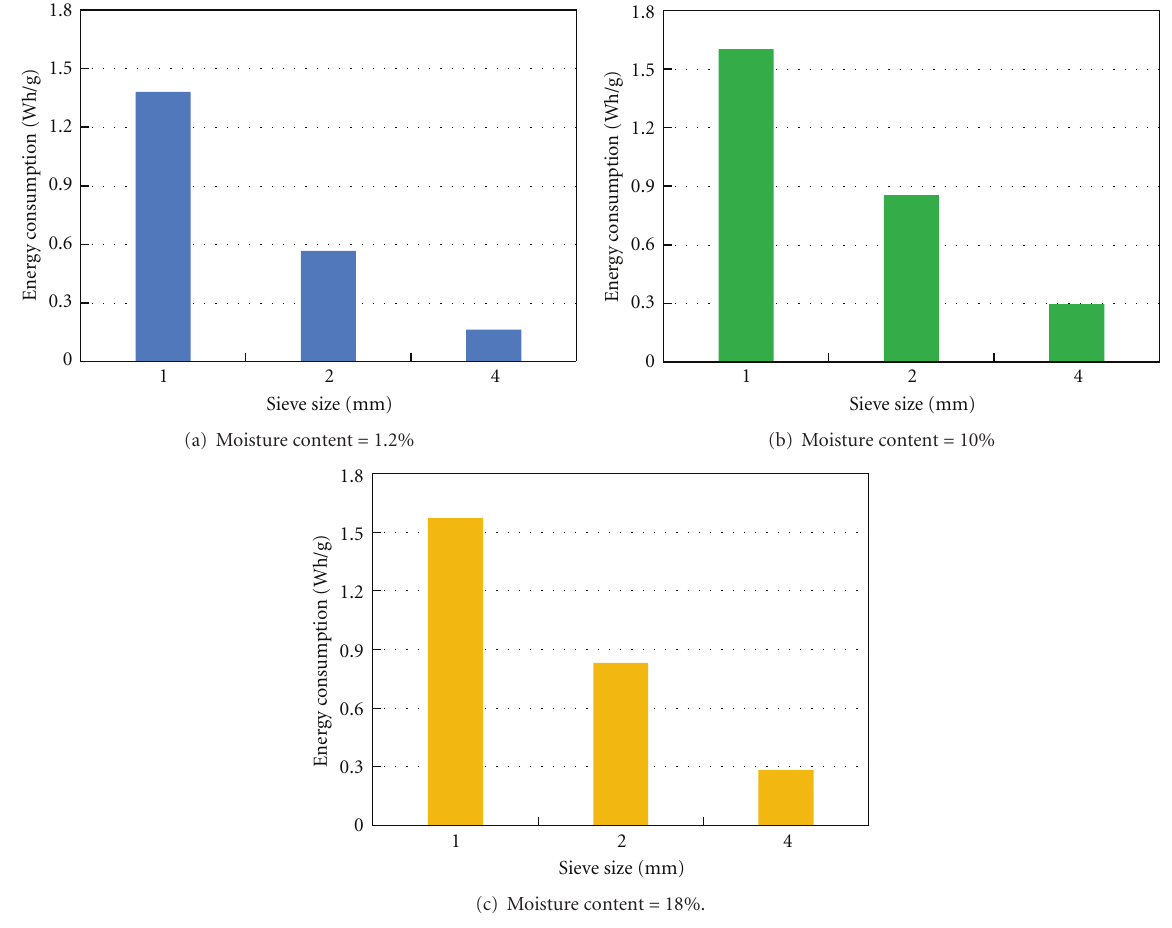
Figure 10: E ff ects of sieve size on energy consumption in knife